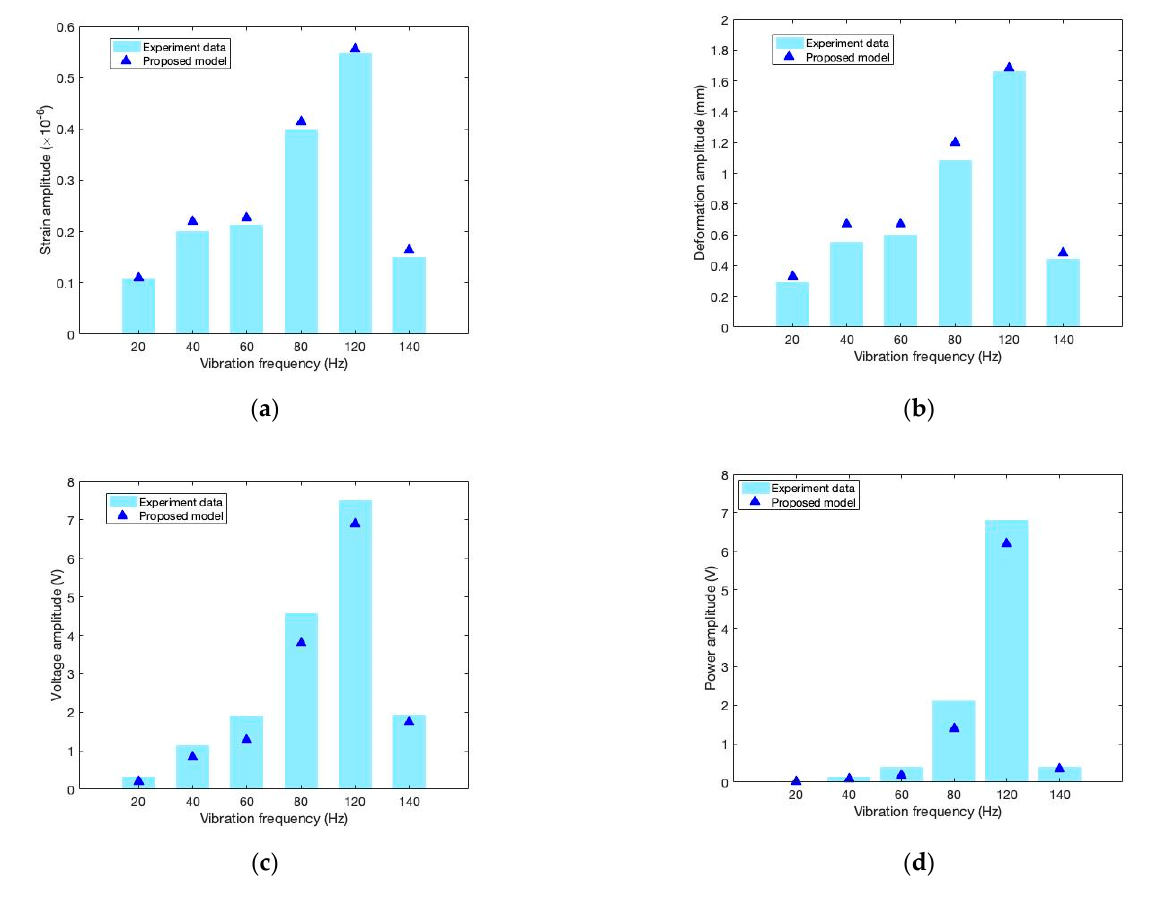
Figure 17. Changing law of responses’ amplitudes with vibration frequency. ( a ) Strain amplitude vs. vibration frequency; ( b ) Deformation amplitude vs. vibration frequency; ( c ) Voltage amplitude vs. vibration frequency; ( d ) Power amplitude vs. vibration frequency.